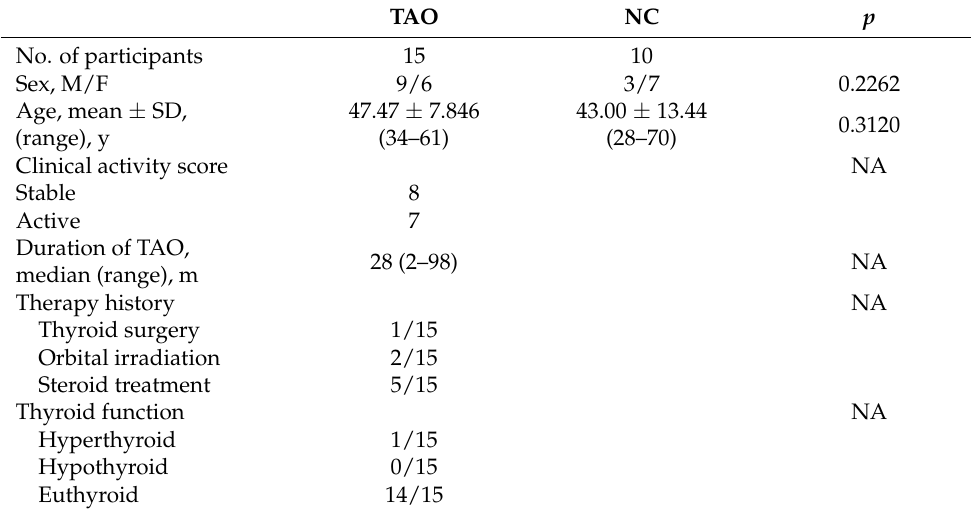
Table 1. Features of patients with TAO and normal controls undergoing